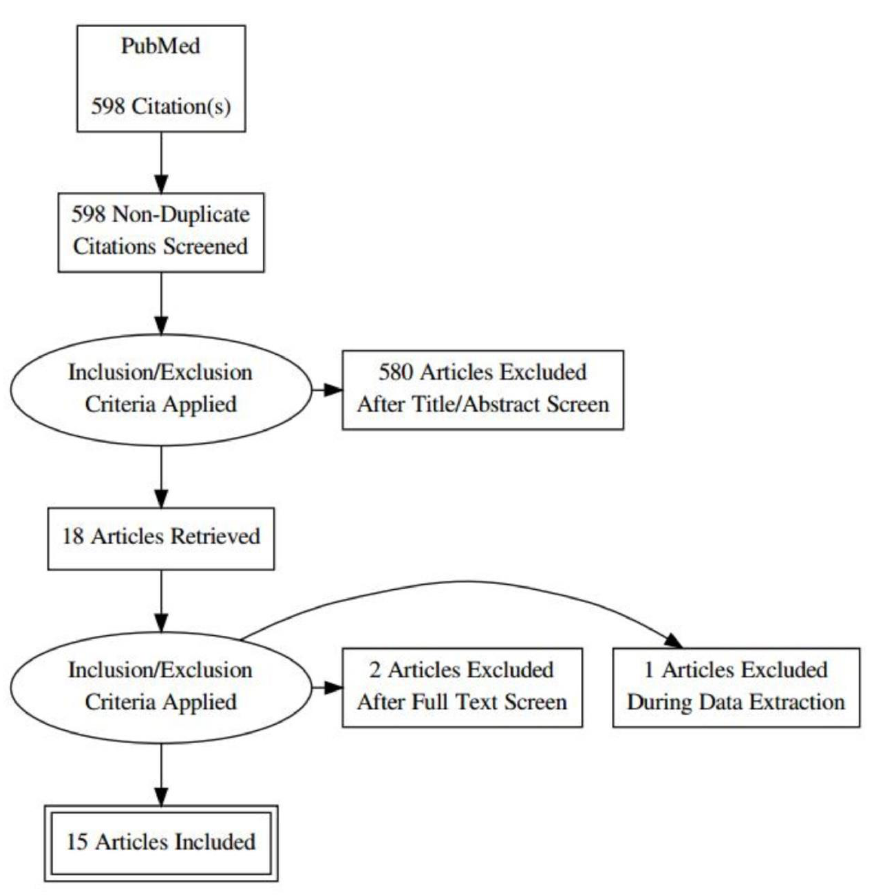
Figure 1. Preferred Reporting Items for Systematic Reviews and Meta-Analyses (PRISMA) flow diagram showing the flow of information through the different phases of the selection process, mapping out the number of records found, included, and excluded.